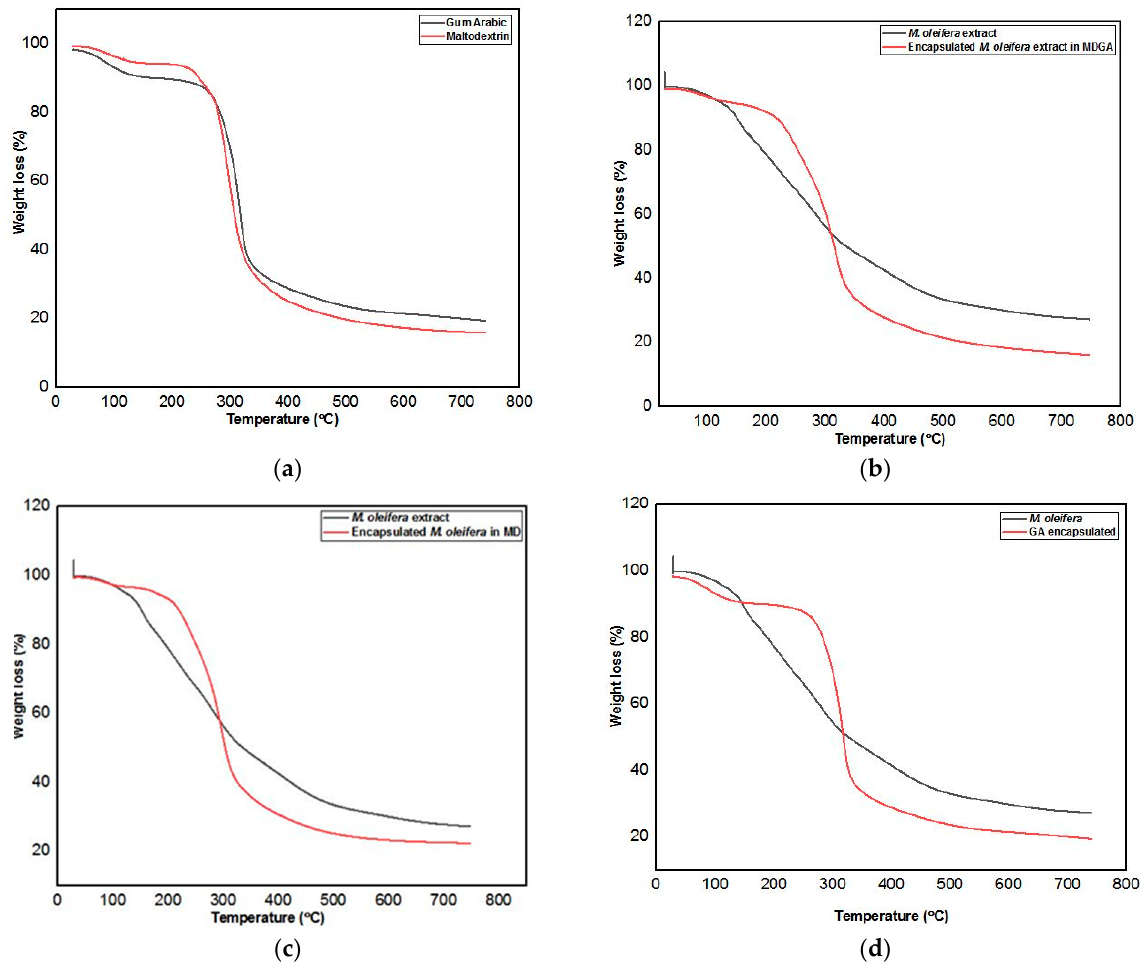
Figure 4. TGA ( a ) plot of pure coating materials ( b ) MDGA encapsulated and M. oleifera extract ( c ) MD encapsulated, and M. oleifera extract ( d ) GA encapsulated and M. oleifera extract.